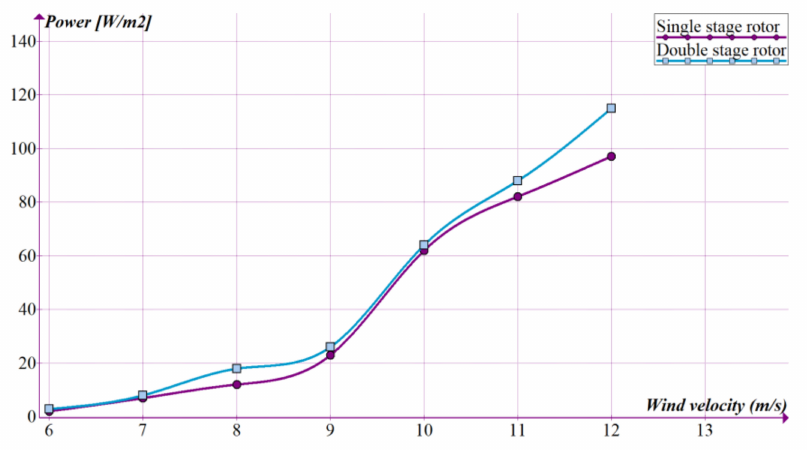
Figure 6. Power obtained for single and double stage rotors [72]. Rotor models with different numbers of blades were also analyzed by Wenehenubun et al. who carried out experimental research on SAVONIUS rotor models with two, three, and four blades (Figure 7) built with an overlap ratio of 0.15, an aspect ratio of 1, and end plates whose diameter exceeded the rotor blades’ diameter by 10% [73]. The rotor diameter and height were 370 mm, and the blades’ thickness was 2 mm. The experiments were performed in the wind tunnel with wind speeds in the range of 1–10 m/s.